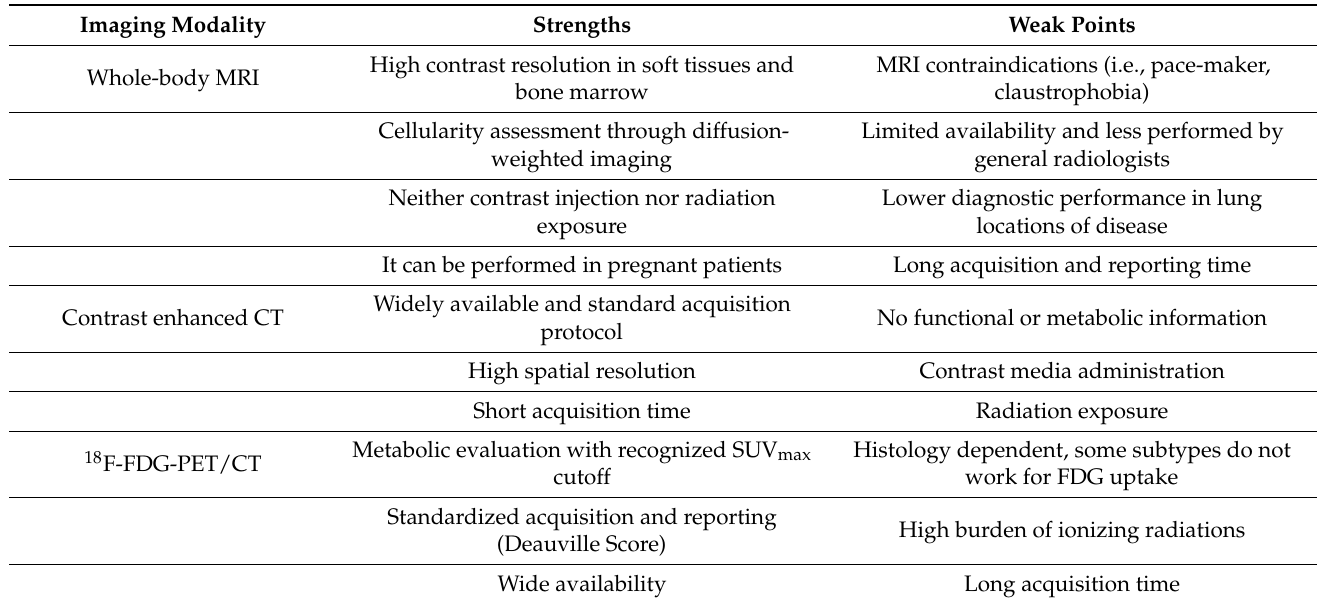
Table 1. Strengths and weak points of the main imaging modalities used in patients with lymphoma. Imaging